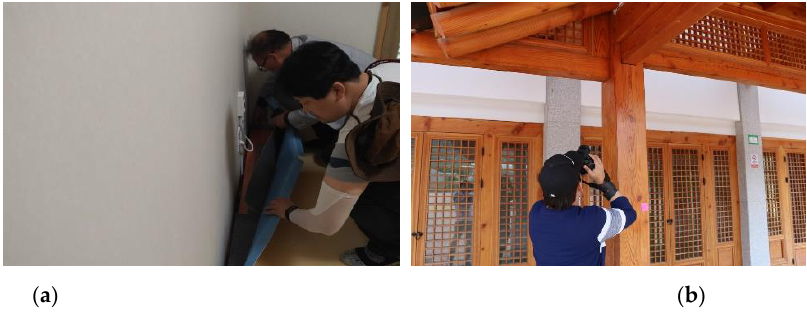
Figure 1. Monitoring method for the Hanok maintenance: visual inspection and photography. ( a ) Tactile and visual inspection; ( b ) Recording through photography.